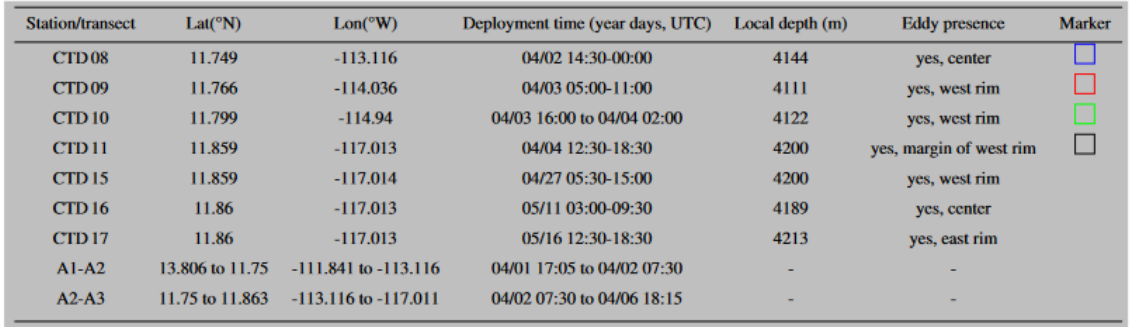
Table 1. Positions and characteristics of CTD and ADCP deployment across the